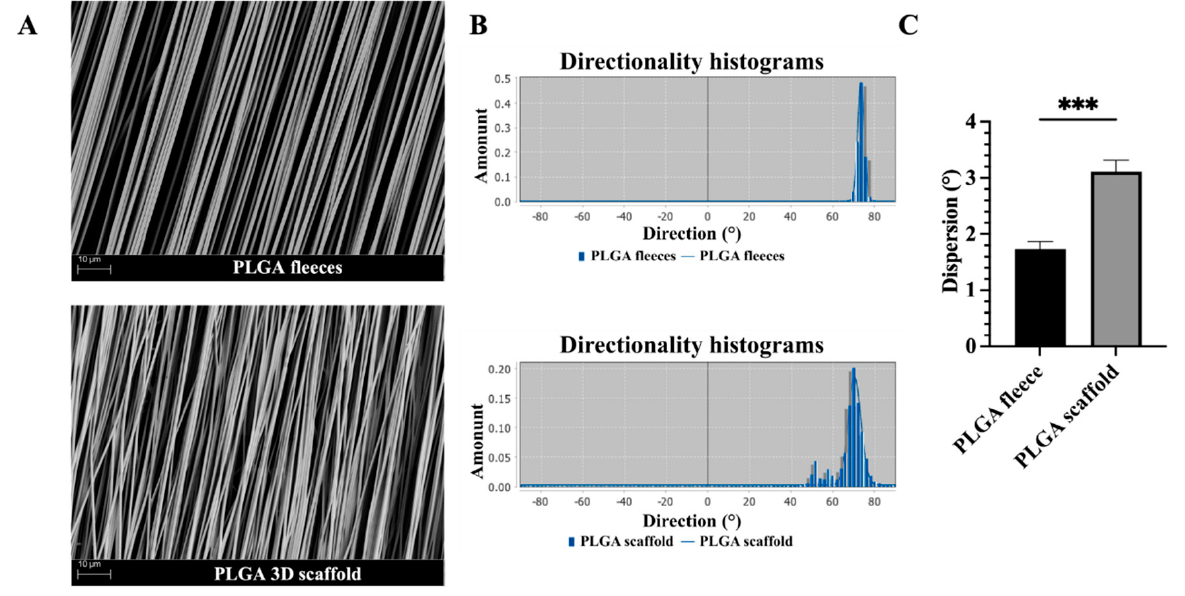
Figure 2. Ultrastructure assessment of electrospun PLGA fleeces and 3D scaffolds. ( A ) SEM micrographs representing the ultrastructural morphology of the produced electrospun PLGA fleeces and 3D scaffolds. All samples showed defect- and bead-free fibers, with high alignment confirming that the rolling-up of the PLGA fleeces does not affect the fiber ultrastructure. ( B ) Fiber orientation of the electrospun PLGA fleeces and scaffolds using Directionality Plugin from ImageJ. Directionality histograms showing the angle distribution (Gaussian curve) of the fibers within the different PLGA fleeces and scaffolds. ( C ) The histogram shows the dispersion values, representing the standard deviation of the Gaussian curves showing the variability in the fiber orientation within the PLGA fleeces and scaffolds. *** Statistically significant between the tested groups ( p < 0.001).